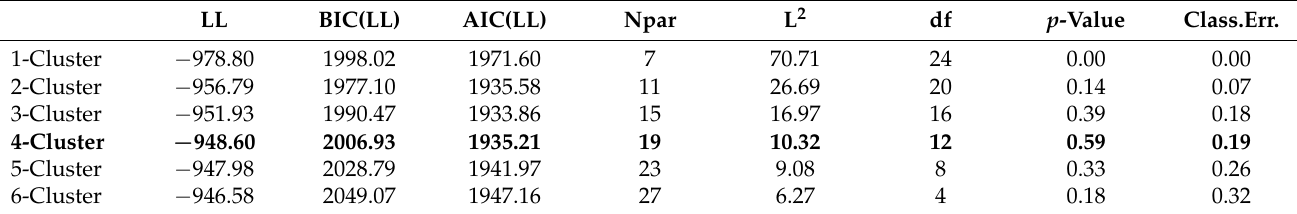
Table 3. Comparison of fit statistics for latent profile analysis models conducted among MSM ( N =